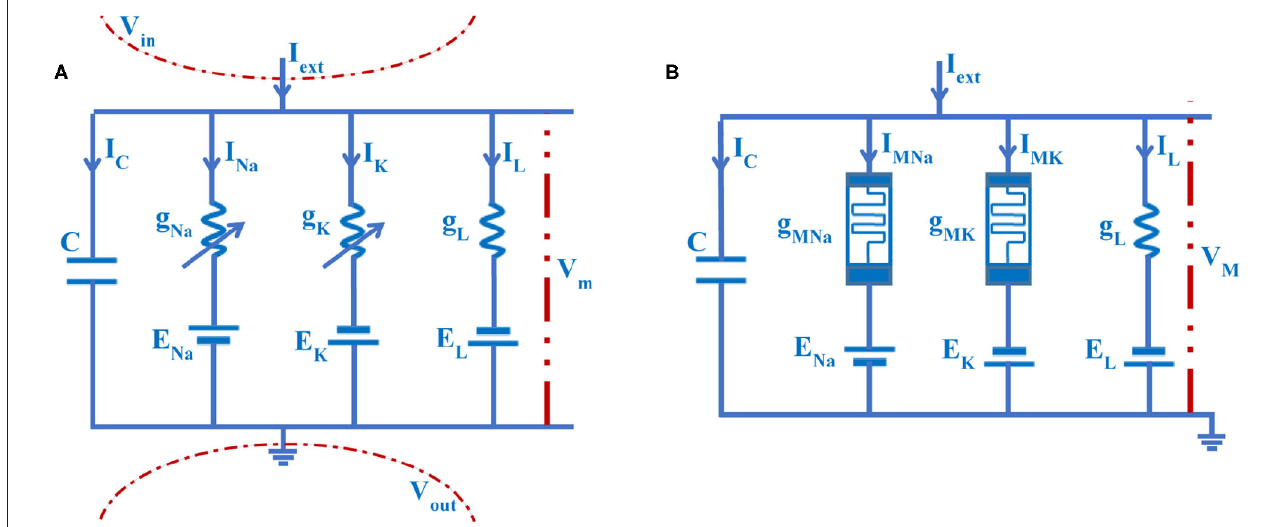
FIGURE 4 | The electrical circuit of the axon cell membrane. (A) The HH circuit model. (B) The MHH circuit